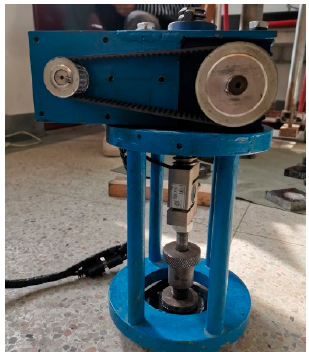
Figure 2. The LGZ-2 structural layer material strength tensile instrument.